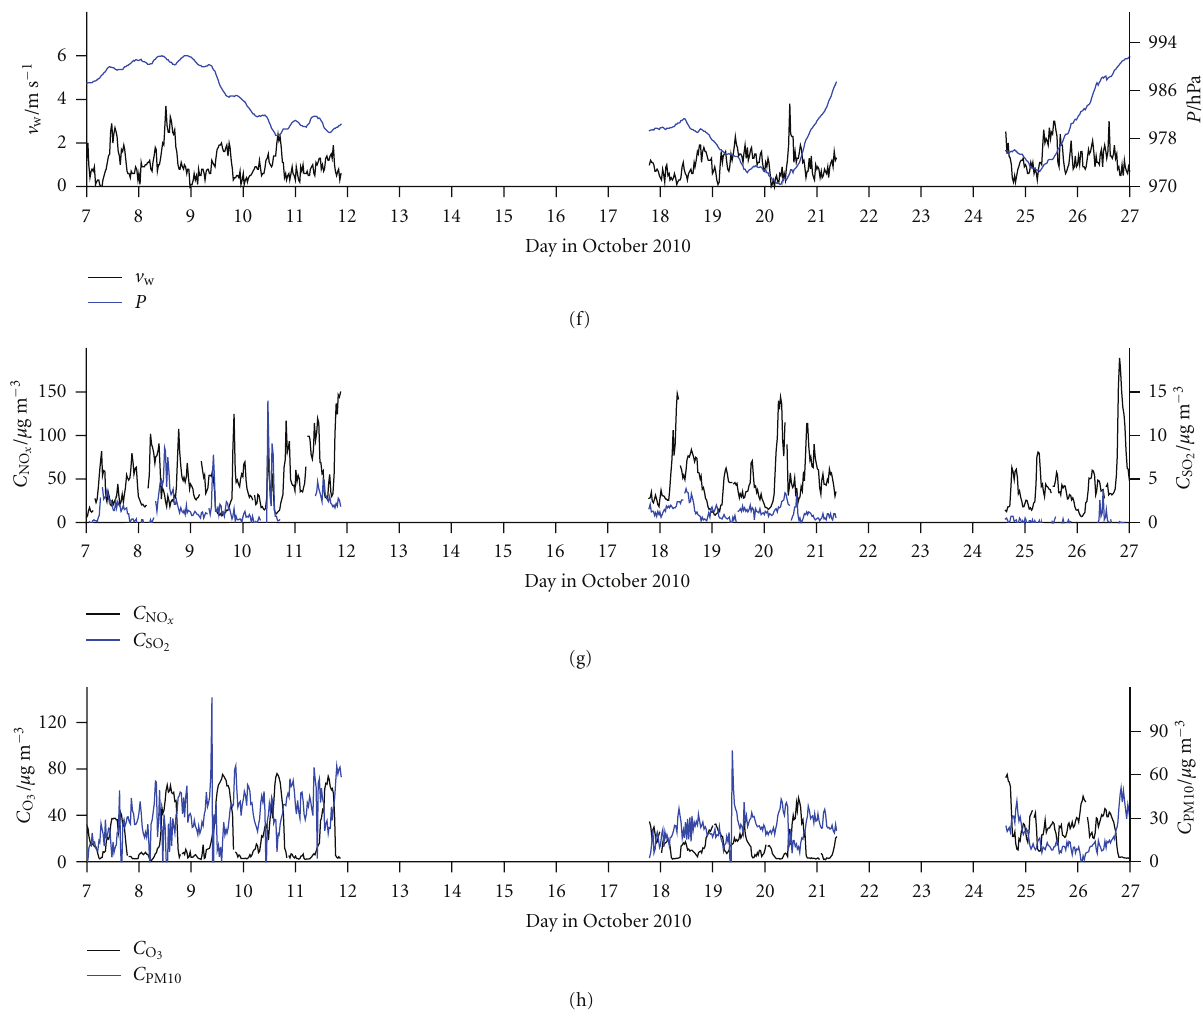
Figure 3: Time run of: (a) the total number concentration of general aerosol particles ( C N (tot)) and geometric mean of their diameters gen ( d GM ), (b) number fraction of particles smaller than 10 nm ( x gen ( < 10)) and smaller than 20 nm ( x gen ( < 20)), (c) precipitation ( h rain ) and solar radiation ( R s ), (d) air temperature ( T ) and air relative humidity ( H rel ), (e) wind velocity ( v w ) and barometric pressure ( P ), (f) concentration ), and (g) concentrations of O 3 ( C O ) and aerosol particles smaller than 10 μ m ( C PM10 ), in outdoor air in front of NO x ( C NO x ) and SO 2 ( C SO 2 3 of the dwelling for the period October 6–26,